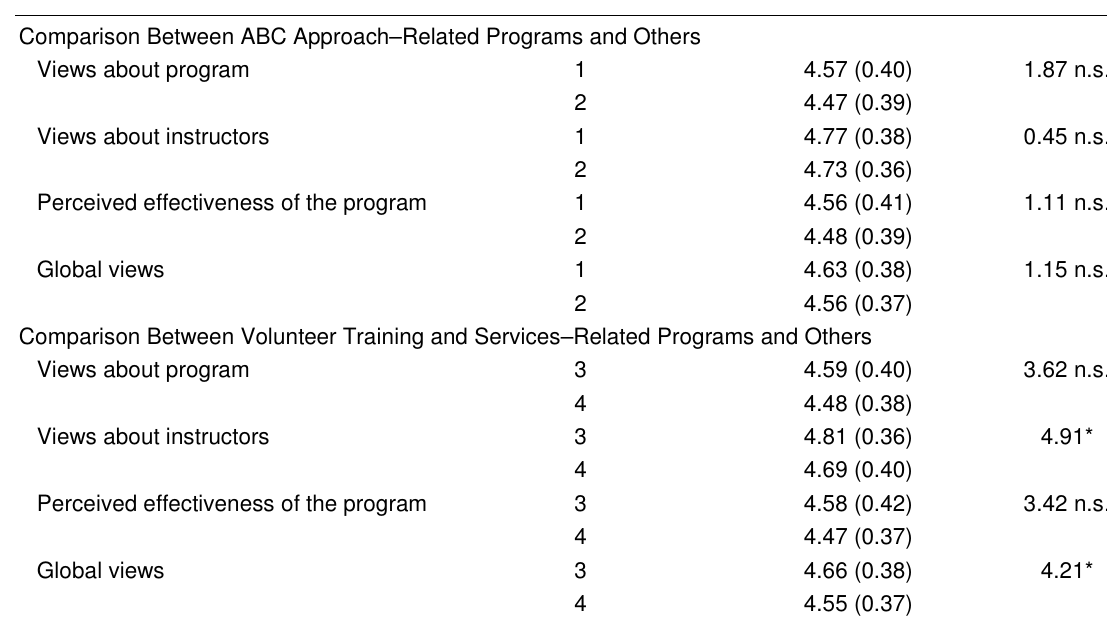
Comparison of the Views About the Tier 2 Program Among Different Program Approaches Variable Program Approach Mean (Standard Deviation)